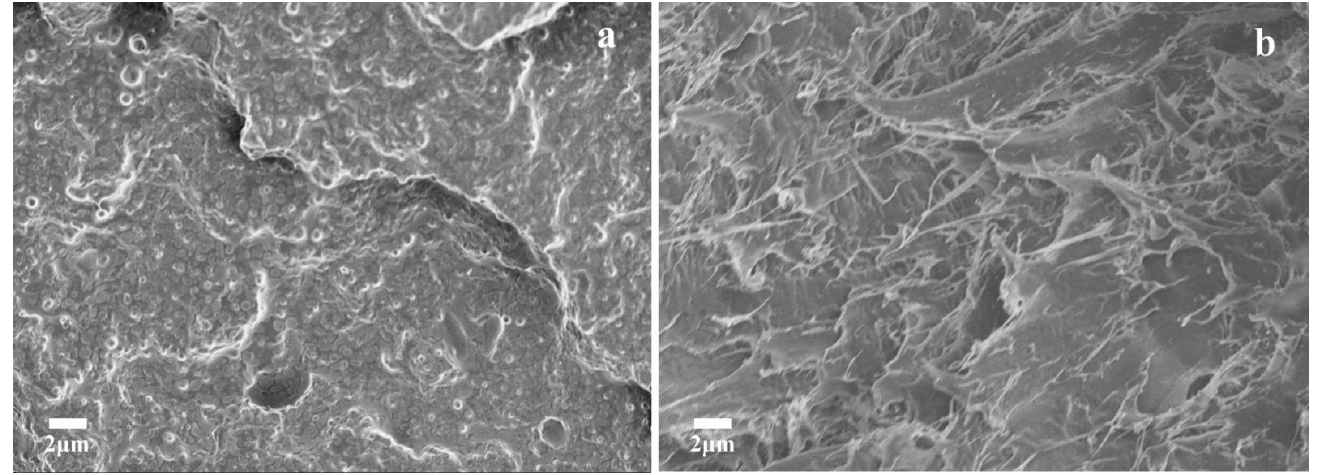
Figure 5. SEM micrographs of tensile-fractured surfaces: ( a ) P70/EP30 and ( b ) P70/EP30/S3 blends.